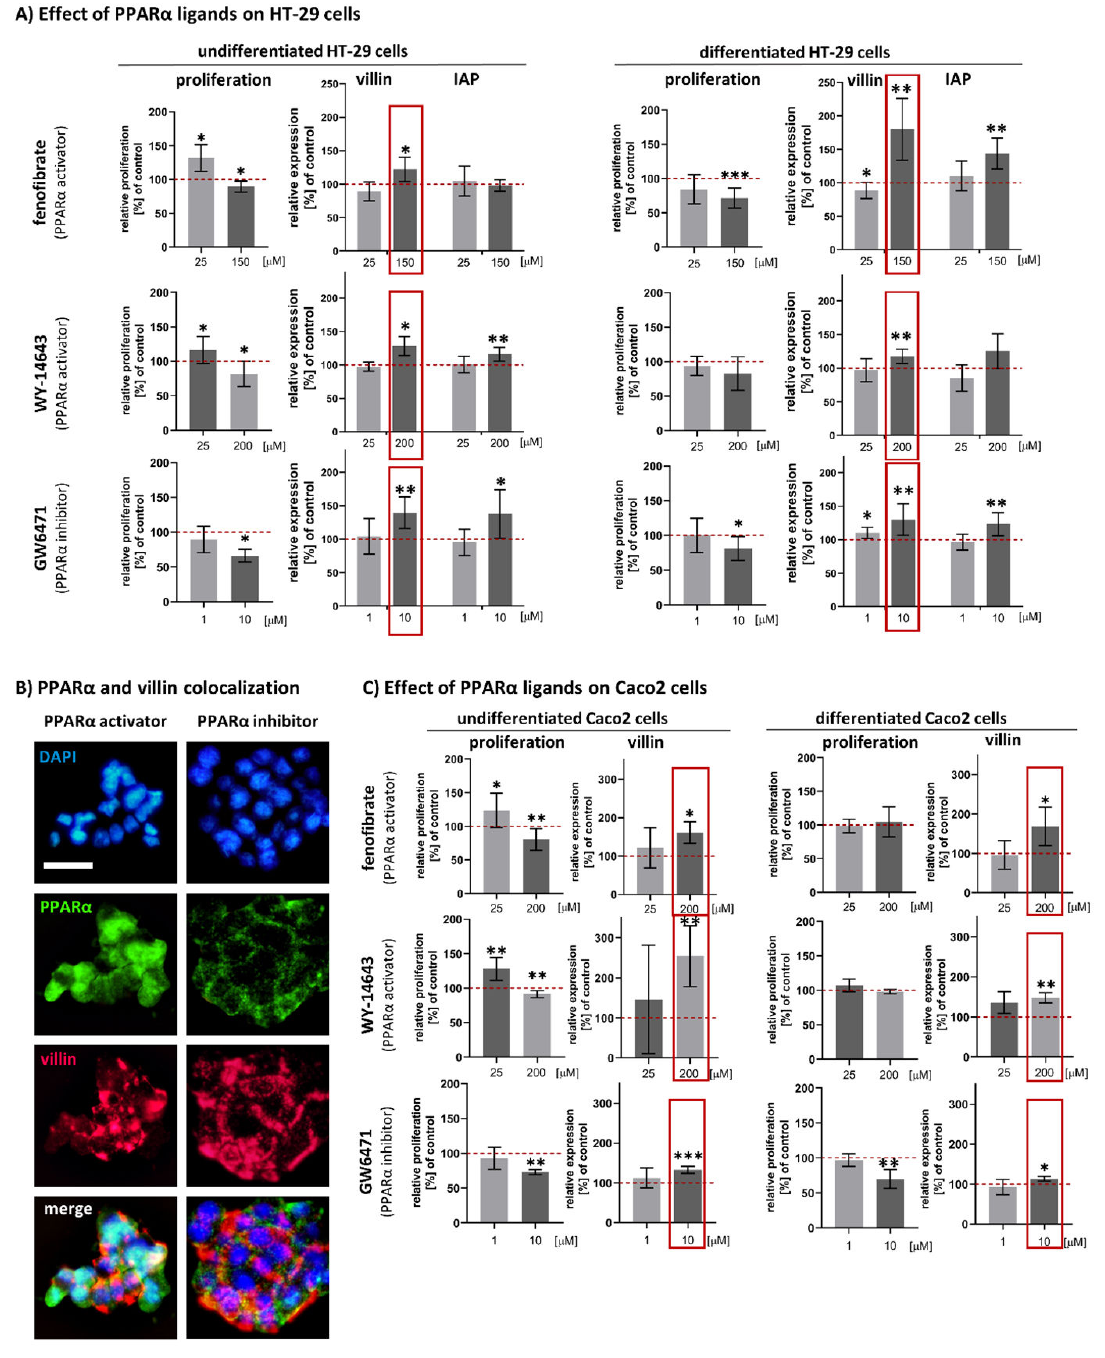
Figure 2. Effects of PPAR α activators (fenofibrate and WY-14643) and PPAR α inhibitor (GW6471) on cell proliferation and differentiation: ( A ) The effect of PPAR α ligands on undifferentiated and sodium butyrate differentiated HT-29 cells. Relative cell proliferation measured by WST-1 assay. Results are shown as the mean ± SD ( n = 9). Relative expression of villin and intestinal alkaline phosphatase (IAP) in comparison to the control was measured by In-Cell ELISA. Results are shown as the mean ± SD ( n = 6). The red dotted lines represent control cells: DMSO-treated undifferentiated or differentiated cells (100%). ( B ) Co-localisation of PPAR α and villin expression in HT-29 cells. The cells were treated with 150 µ M fenofibrate (PPAR α activator) and 10 µ M GW6471 (PPAR α inhibitor). Fenofibrate treatment favoured nuclear localisation of PPAR α , whereas GW6471 treatment retained PPAR α in cytoplasm. The villin expression was independent of subcellular localisation of PPAR α . All microphotographs are in the same magnification (400x); the white line repre- sents 10 µ m. ( C ) Effect of PPAR α ligands on undifferentiated and spontaneously differentiated Caco2 cells. Relative cell proliferation measured by WST-1 assay. Results are shown as the mean ± SD ( n = 9). Relative expression of villin in comparison to the control was measured by In-Cell ELISA. Results are shown as the mean ± SD ( n = 6). The red dotted line represents control cells: DMSO-treated undifferentiated or differentiated cells (100%). Note the increase in villin expression in both used cell lines after PPAR α treatment (red rectangles). Statistically significant results in comparison to control cells are marked by * p ≤ 0.05, ** p ≤ 0.01, *** p ≤